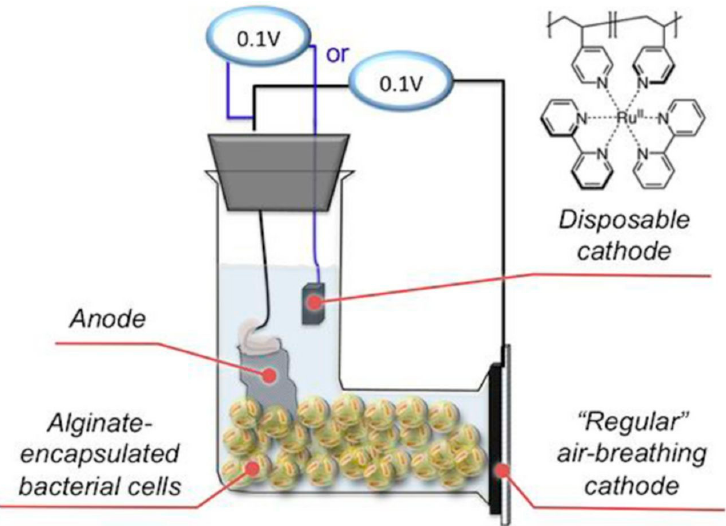
Figure 4. Self-powered hypersaline microbial electrochemical biosensor. Alginate encapsulated Salinivibrio sp. EAGSL cells were added to a single-chamber microbial fuel cell with a disposable ruthenium modified ([Ru(bpy) 2 (PVP) 5 ]•Cl 2 (PVP-Ru(bpy) 2 Cl 2 )) cathode for increased sensitivity. Reproduced with permission from M. Grattieri, D.P. Hickey, B. Alkotaini, S.J. Robertson, and S.D. Minteer. Hypersaline Microbial Self-Powered Biosensor with Increased Sensitivity. J.